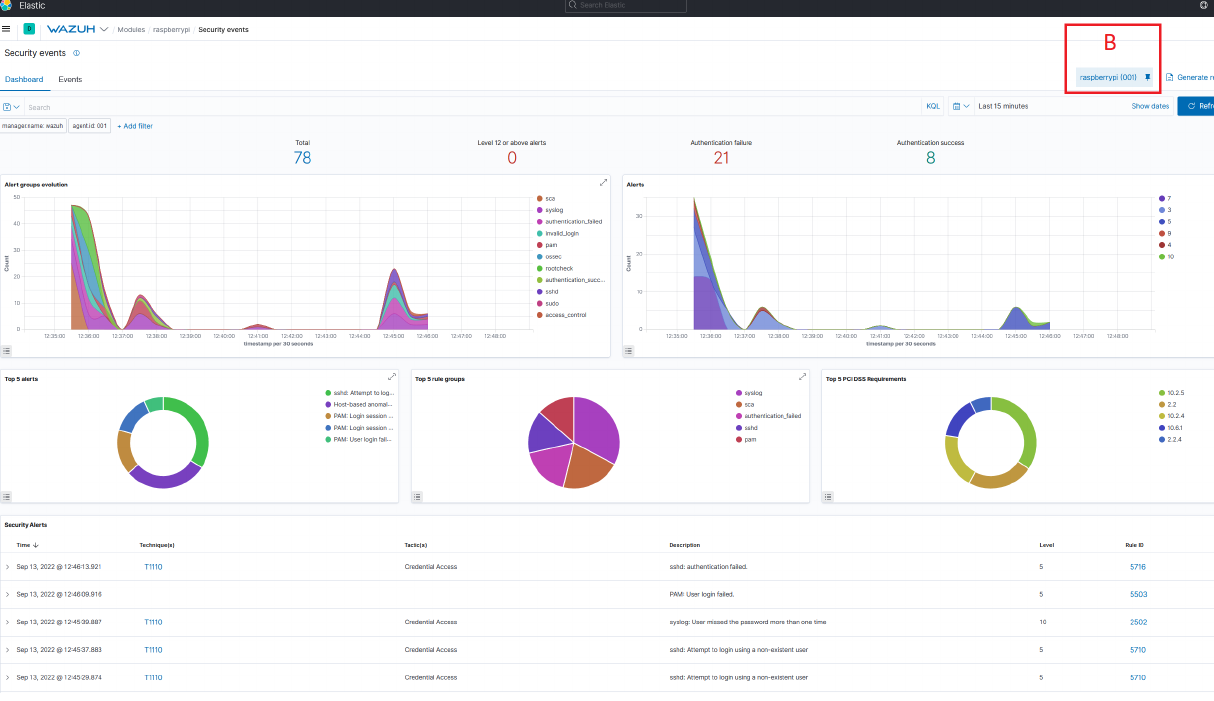
Figure A2. Analyzing events of one asset in Wazuh (B showcases the agent